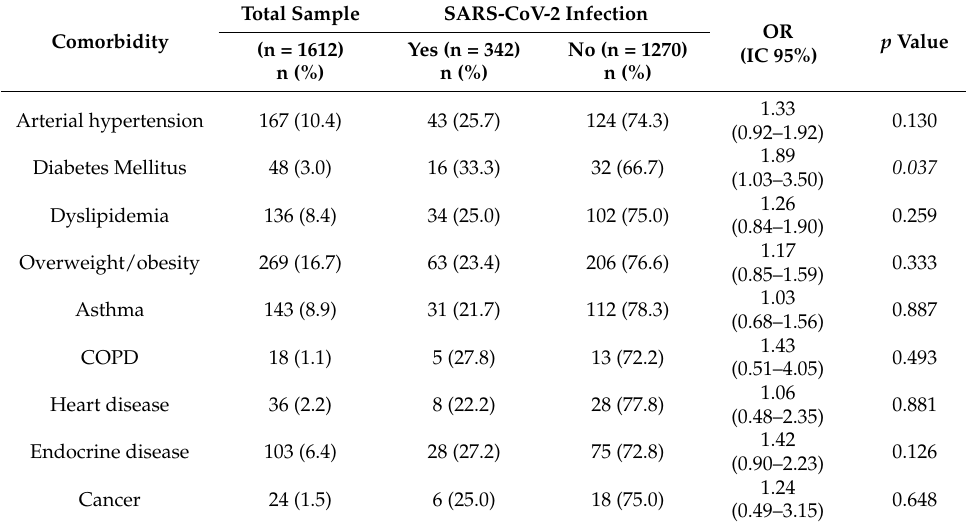
Table 2. Comorbidity in patients with or without SARS-CoV2 infection.